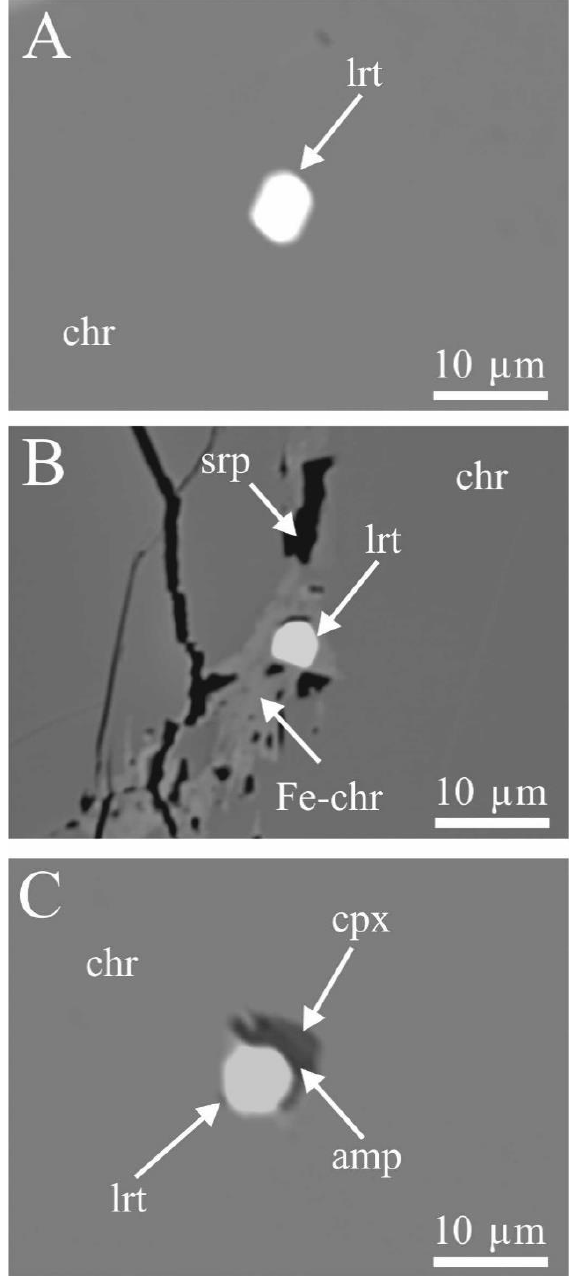
Figure 10. BSE images of magmatic laurite from Kabaena Island chromitite: single-phase enclosed in fresh chromite ( A ), single phase in contact with ferrian chromite ( B ), and the inclusion of laurite and silicates ( C ). Abbreviations: lrt = laurite, chr = chromite, srp = serpentine, Fe-chr = ferrian chromite, cpx = clinopyroxene, and amp = amphibole.